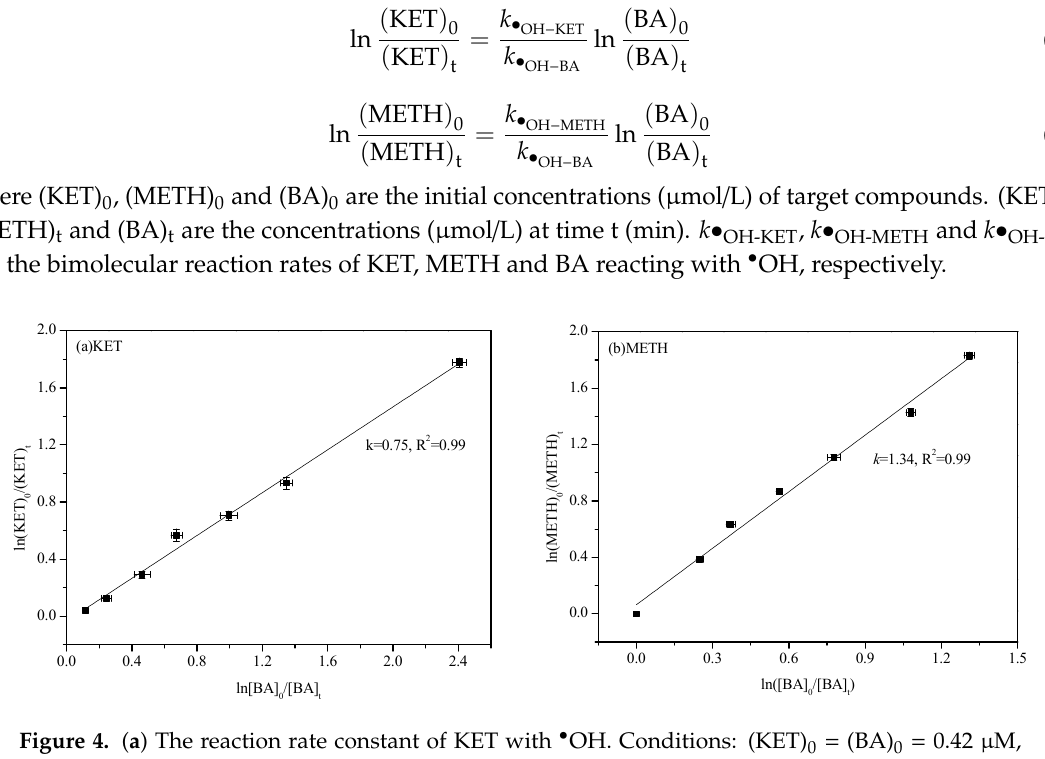
Figure 4. ( a ) The reaction rate constant of KET with • OH. Conditions: (KET) 0 = (BA) 0 = 0.42 µ M, (H 2 O 2 ) 0 = 1 mM, pH = 7, T = 25 ± 1 ◦ C. ( b ) The reaction rate constant of METH with • OH. Conditions: (METH) 0 = (BA) 0 = 0.67 µ M, (H 2 O 2 ) 0 = 1 mM, pH = 7, temperature = 25 ± 1 ◦ C.